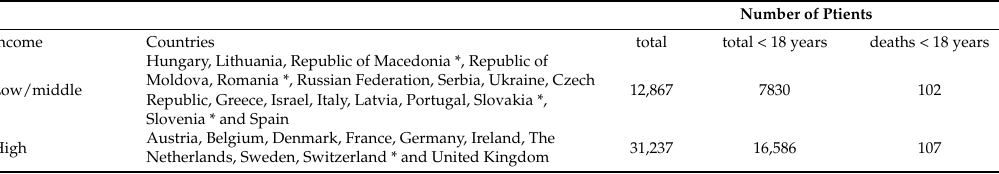
Table 3. ECFSPR countries by group of